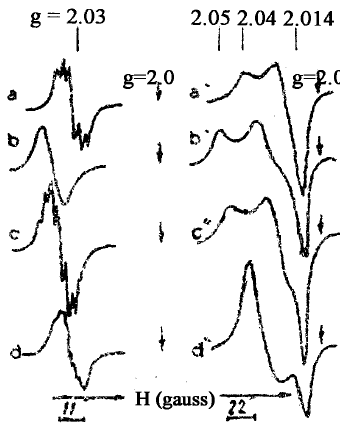
Figure 4. The EPR spectra of DNIC with hydroxyl (pH 12.0) (curves ( a , a ′ )), water (pH 7.0) (curves ( b , b ′ )), phosphate (curves ( c , c ′ )) and cysteine (curves ( d , d ′ )) recorded at ambient temperatures ( b , b (cid:48) )), phosphate (curves ( c , c (cid:48) )) and cysteine (curves ( d , d (cid:48) )) recorded at ambient temperatures (curves ( a − d )) or at 77K (curves ( a ′ − d ′ )) Arrows show magnetic field position corrsponding to g = (curves ( a − d )) or at 77K (curves ( a (cid:48) − d (cid:48) )) Arrows show magnetic field position corrsponding to 2.0 [54]. g = 2.0